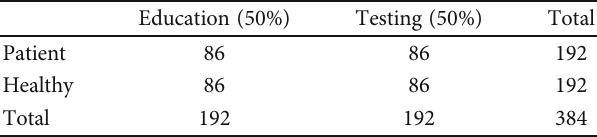
Figure 5: Separating the data set into training and test data sets. Table 1: Training and test set